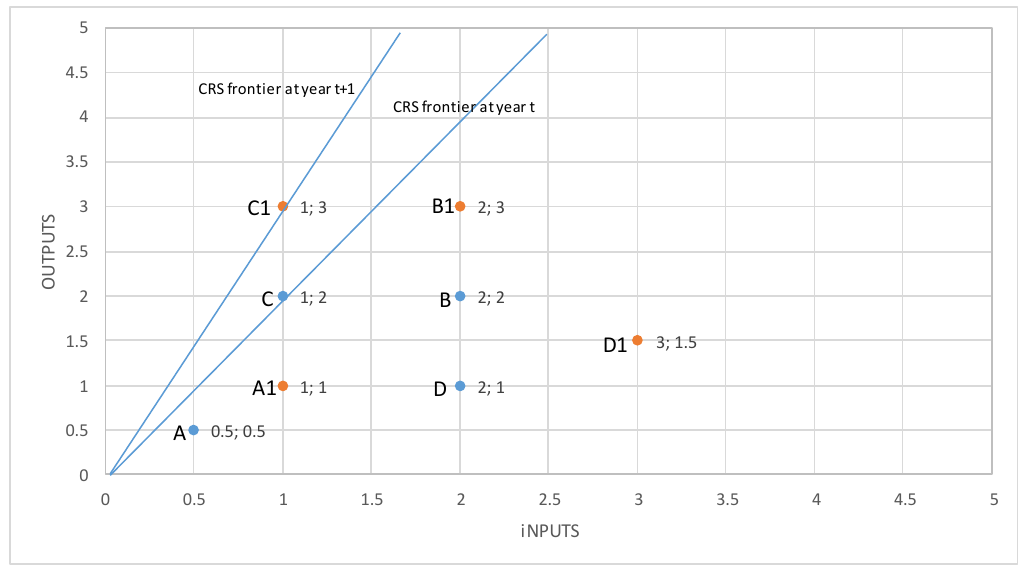
Figure 1. The Malmquist index using a constant return of scale DEA model Note: This figure presents an example of how the Malmquist index is represented by means of the DEA distance function. A, B, C and D represent the input/output efficiency of four firms in year t and A1,B1,C1,D1 in year t+1. The Malmquist index calculates the change in the distance of each unit to the efficiency frontier, regarding period t and t+1.